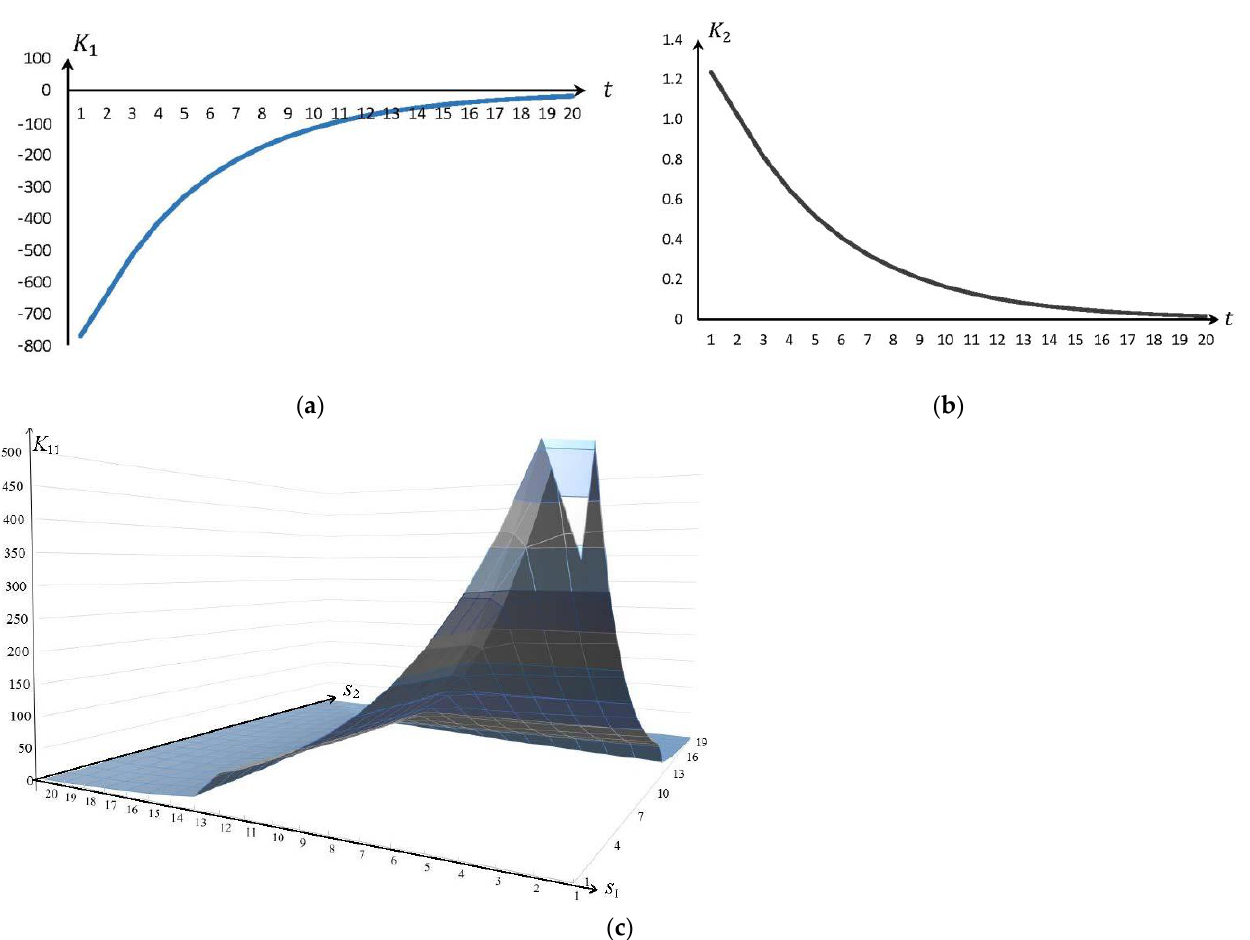
Figure 3. Mesh analogs for the kernels: ( a ) K 1 ; ( b ) K 2 ; ( c ) K 11